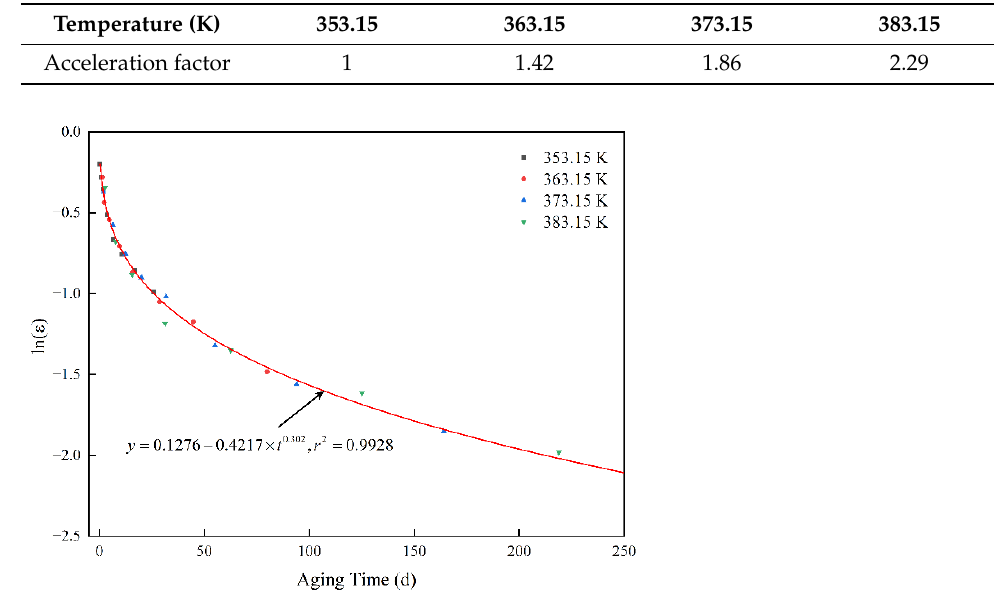
Figure 3. Aging data and nonlinear regression after time–temperature equivalent